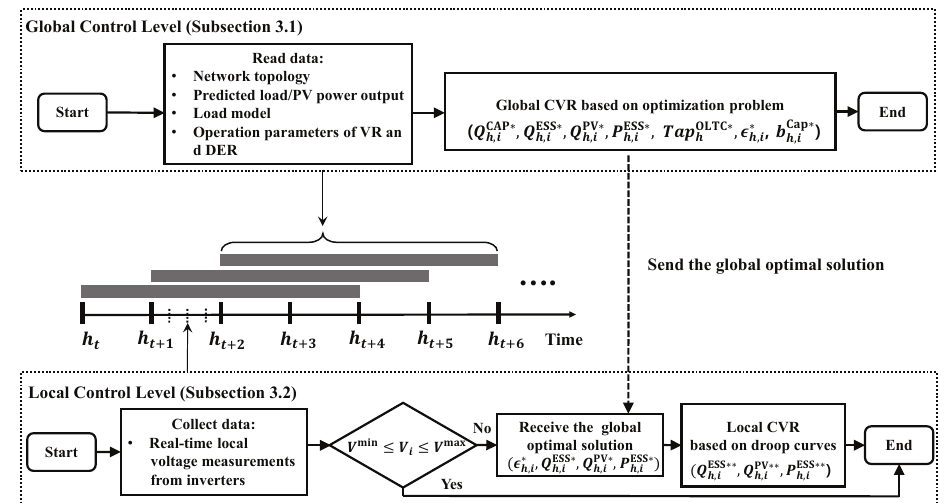
Figure 1. Flowchart of the procedure of the proposed hierarchical look-ahead conservation voltage reduction (CVR)